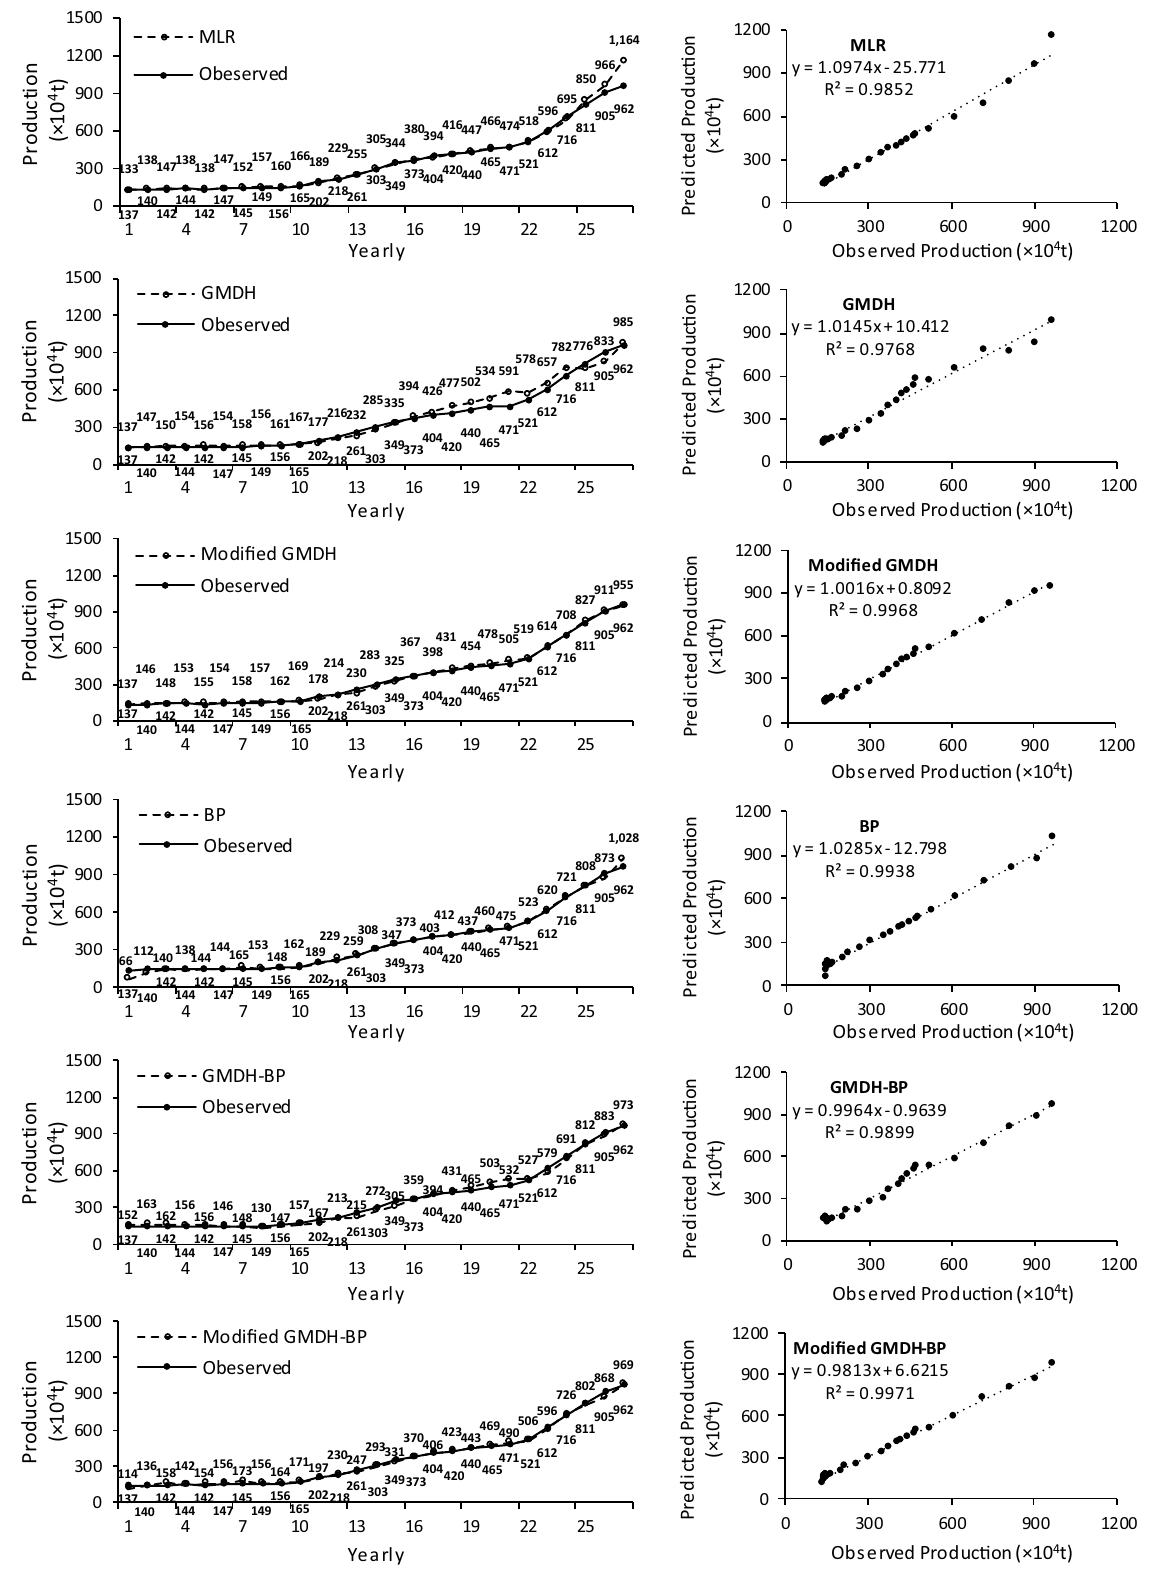
Fig. 4 Comparison of the performances of MLR, GMDH, modified GMDH, BP, GMDH-BP, and modified GMDH-BP models for oilfield fore-